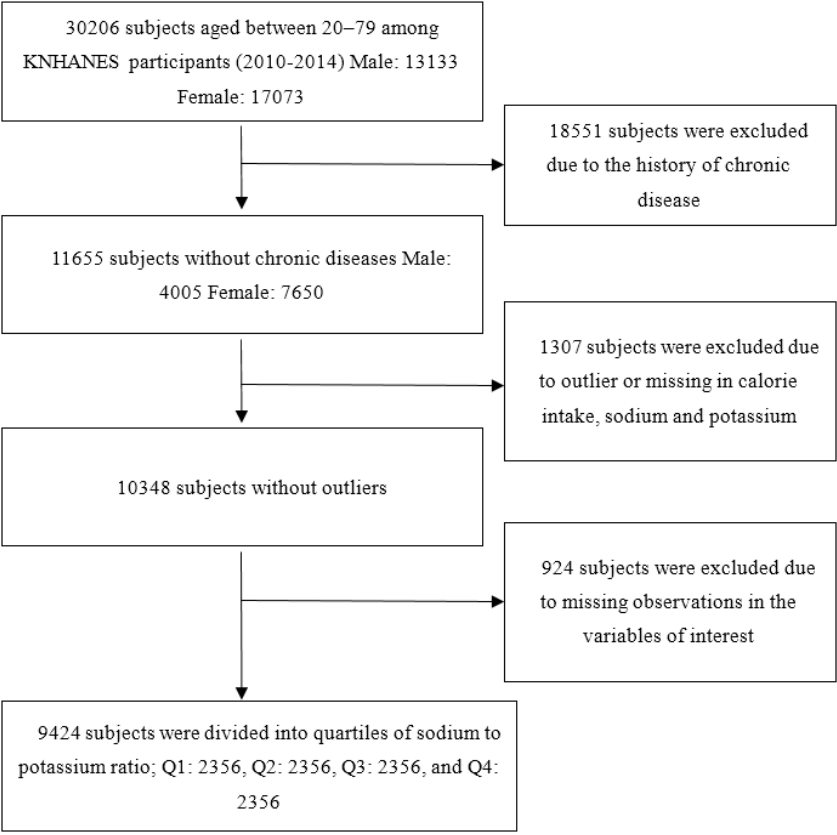
Figure 1. Study population flow.